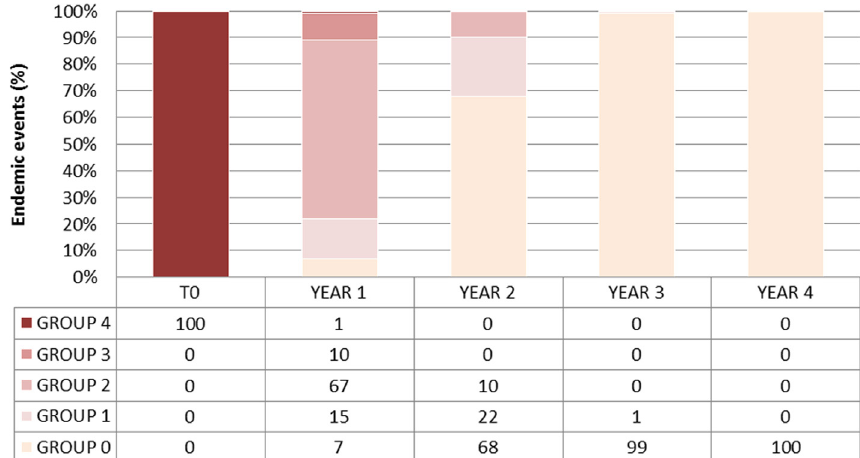
Figure 7. Occurrences of endemic events and of extinction of sleeping sickness in Lambi, with a 70% medical cover and vector control device (6 traps/km 2 ). Group 0 = no case or elimination, group 1 = 1 case, group 2 = from 2 to 5 cases (low endemic level), group 3 = from 6 to 25 cases (high endemic level) and group 4 = more than 25 cases (epidemic